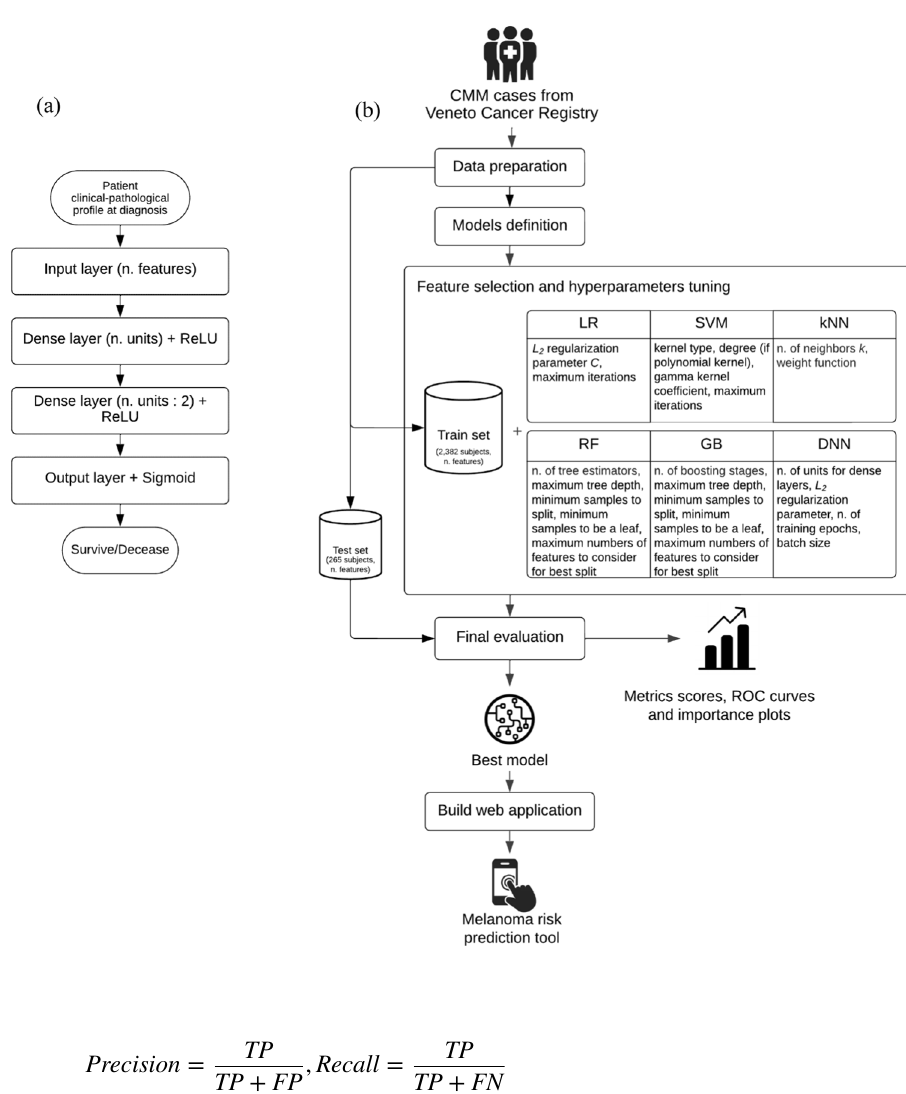
Fig. 2 Methods overview of the study: a Deep Neural Net- work architecture diagram, b data and machine